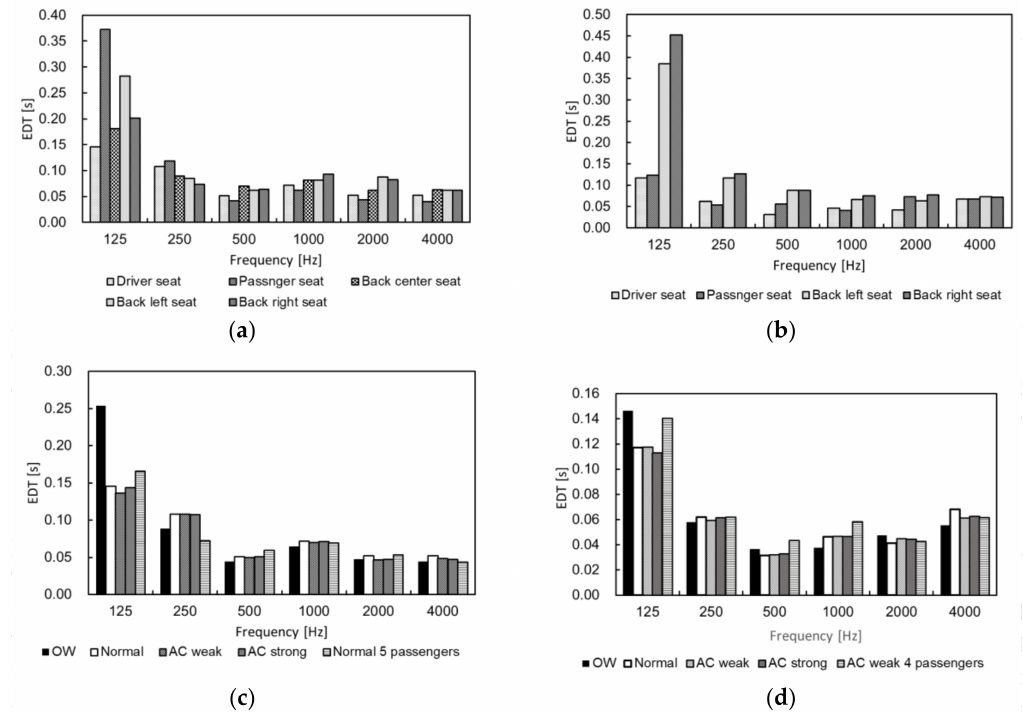
Figure 5. Measured early decay time ( EDT ) [s] at each passenger position in cars ( a ) A and ( b ) B and under open-window (OW), air-conditioner (AC) and multiple passenger settings in cars ( c ) A and ( d ) B.